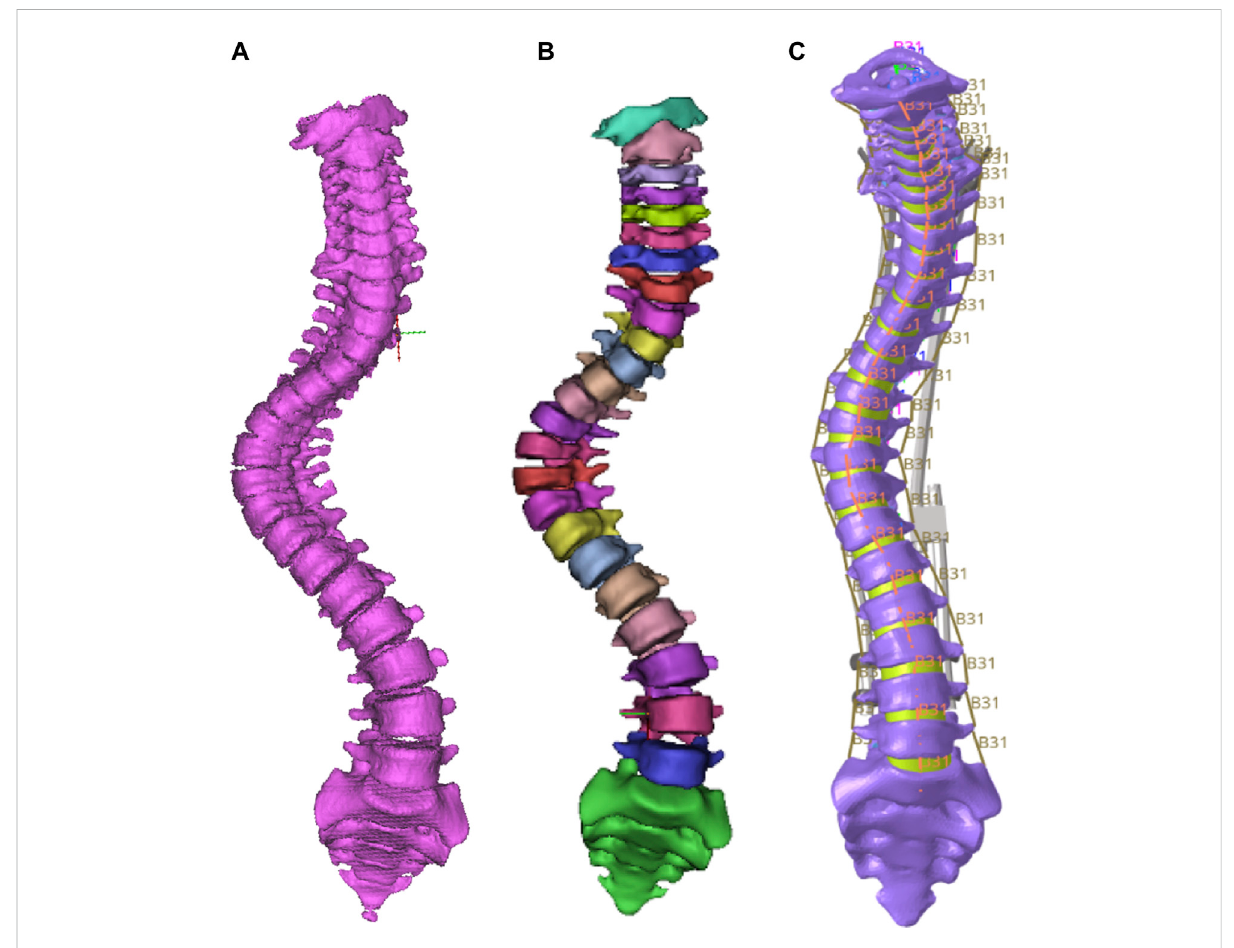
FIGURE 2 The original spine model (A) and FEM before (B) and after (C)